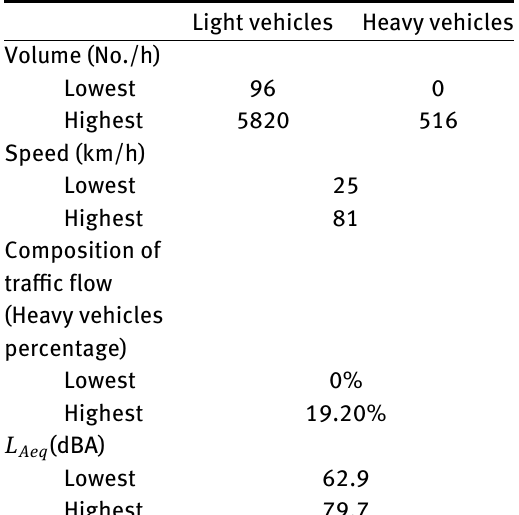
Table 1: Range observed for the main traflc and noise characteristics.